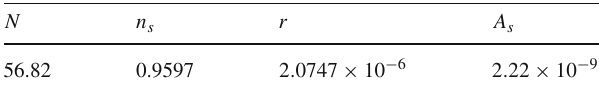
Fig. 6 A plot of scalar potential in Eq. (70), one of the models belong- ing to Case 2 with γ = 1 and β = 0. We choose a = 2 . 34422 × 10 − 6 , b = − 0 . 0234, c = 7 . 10 × 10 − 6 , ξ = 0 . 3023, α = − 0 . 7813. The vertical (red) line indicates φ ∗ Table 2 The theoretical predictions for φ ∗ = 64 . 5316 and φ end = 50 . 9915 and the parameters given in Fig. 6